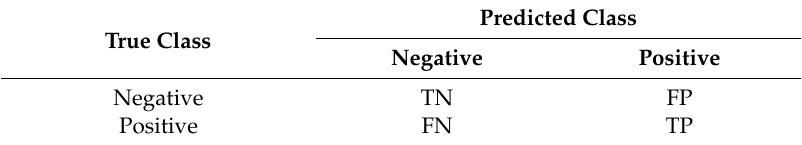
Table 4. Deep FC1 features and DT classifier.